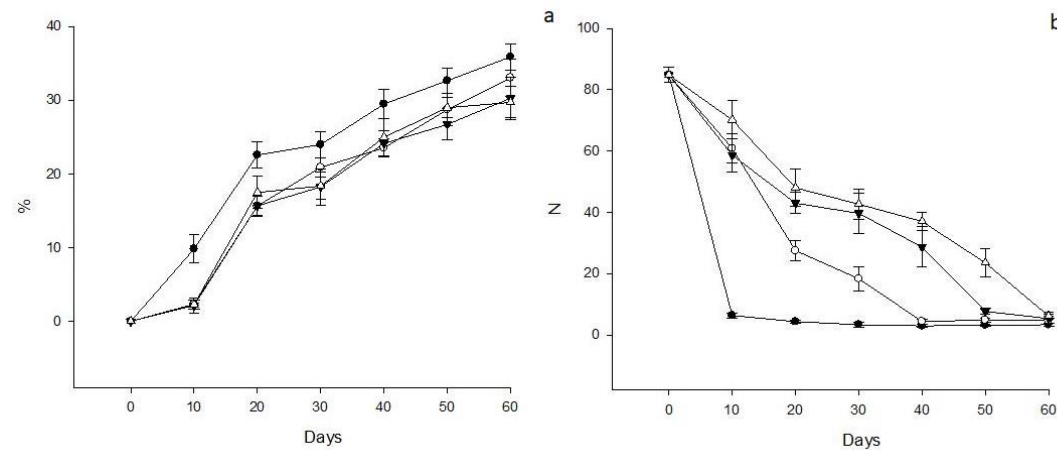
Figure 1. ( a ) Result for the percentage of weight loss in avocado. ( b ) Result for firmness in avocado. The results are expressed as means ± standard deviation. N = Newtons. ● = C, ▼ = N25, △ = N50, ○ = CN.